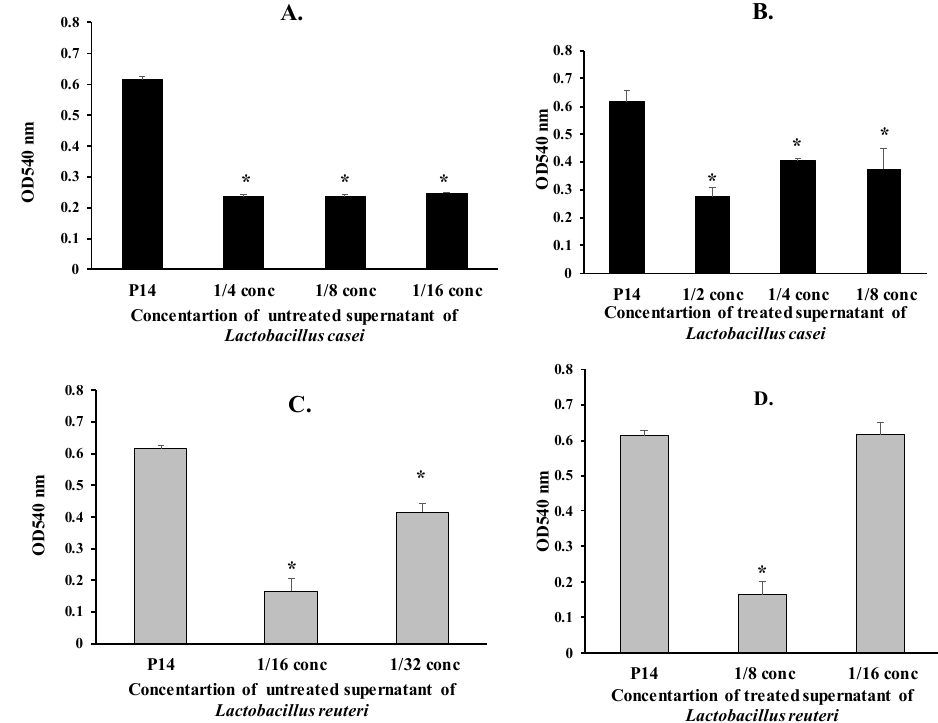
Figure 2. E ff ect of supernatants of L. casei and L. reuteri on mature biofilm formation of the P. mirabilis isolate P14 (* p < 0.05). ( A ) E ff ect of untreated supernatants of L. casei on mature biofilm formation of the Proteus isolate P14 (* p < 0.05). ( B ) E ff ect of treated supernatants of L. casei on mature biofilm formation of the Proteus isolate P14 (* p < 0.05). ( C ) E ff ect of untreated supernatants of L. reuteri on mature biofilm formation of the Proteus isolate P14 (* p < 0.05). ( D ) E ff ect of treated supernatants of L. reuteri on mature biofilm formation of the Proteus isolate P14 (* p <